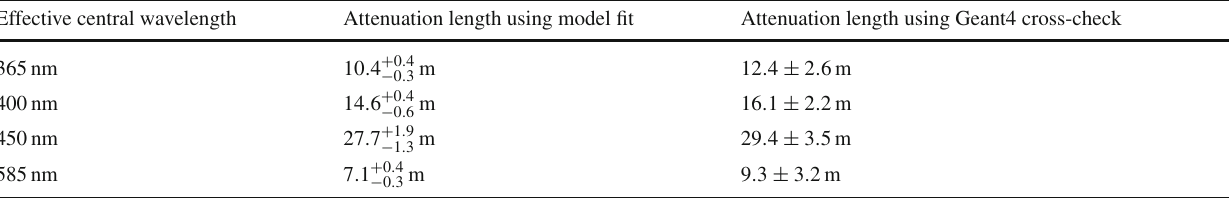
Table 2 Results of the combined attenuation-length model fit , using all available data (central column, see also Fig. 5), compared to the Geant4 cross-check (right column) Effective central wavelength Attenuation length using model fit Attenuation length using Geant4